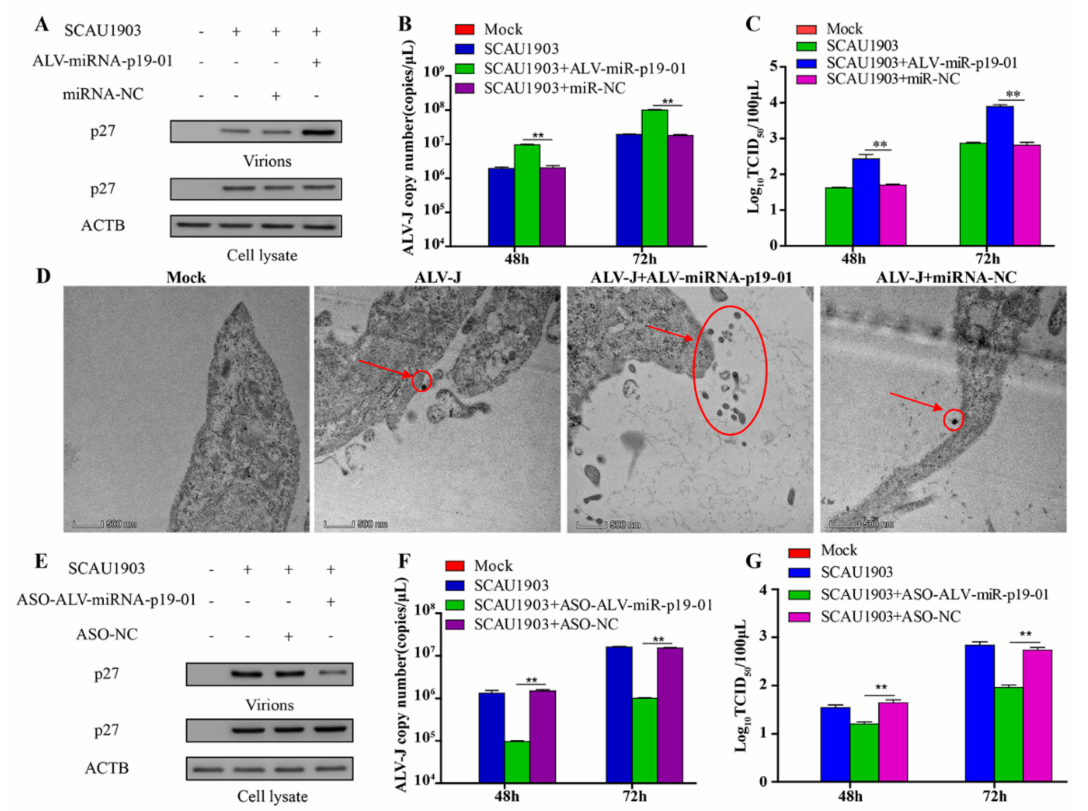
Figure 3. ALV-miRNA-p19-01 promotes ALV-J SCAU1903 replication. ( A – C ) DF-1 cells respectively transfected with ALV-miRNA-p19-01 mimic and miR-NC were infected with ALV-J SCAU1903 at 4 hpt. ( A ) The expression of p27 protein were examined by Western Blot. ( B ) The transcriptional level of viral particles in supernatants were measured by RT-PCR. ( C ) The supernatants from infected cells were titrated in DF-1 cells by ELISA for TCID50. ( D ) ALV-miRNA-p19-01 mimic was transfected into DF-1 cells and miR-NC was used as a control. DF-1 cells were infected with ALV-J SCAU1903 at 4 hpt and processed for transmission electron microscopy as described in Materials and Methods. ( E – G ) DF-1 cells respectively transfected with ASO-ALV-miRNA-p19-01 and ASO-NC were infected with ALV-J SCAU1903 at 4 hpt. ( E ) The expression of p27 protein were examined by Western Blot. ( F ) The transcriptional level of viral particles in supernatants were measured by RT-PCR. ( G ) The supernatants from infected cells were titrated in DF-1 cells by ELISA for TCID50. Statistically significant values are indicated by ** p <